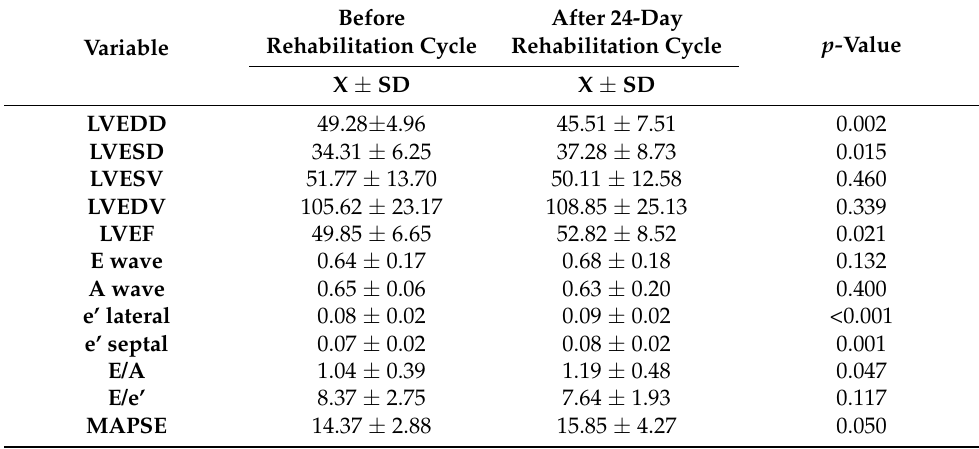
Table 7. Results of echocardiographic tests carried out before and after the 24-day rehabilitation